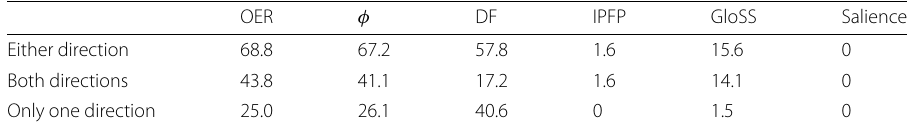
Table 17 Percentage of disease pairs retained by different constructed networks whose gene or PPI commonality are deemed significant by Ref. Park et al.